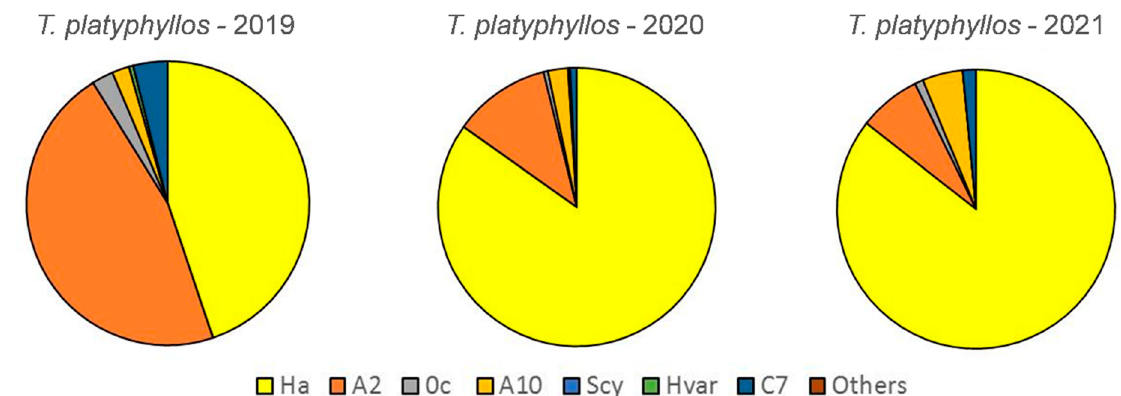
Figure 2. Relative abundance of the different ladybird species on L. tulipifera from 2019 to 2021. On T. platyphyllos , A. bipunctata was the prevalent species in 2019. However, a sharp increase in the abundance of H. axyridis relegated this species to second position from 2020. Changes in the species complex abundances were found over the study period ( χ 2 = 226.32; p < 0.0001; df: 10) (Figure 3). Yearly comparisons revealed significant differences between 2019 and 2020, but not between 2020 and 2021 (Table S3).